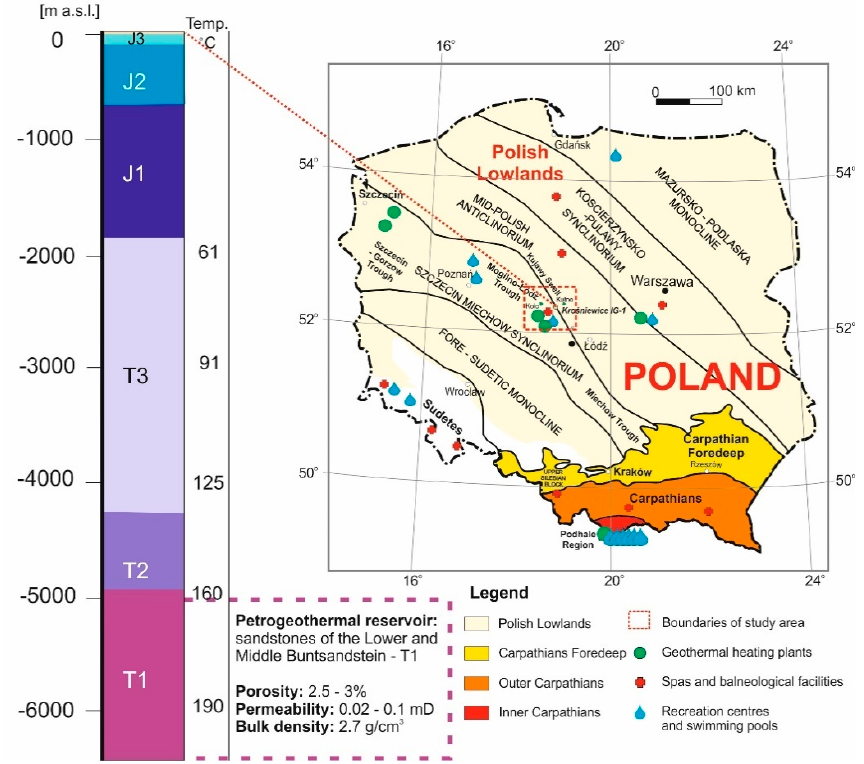
Figure 4. Location of the research area together with the predicted geological profile of Kro ś niewice IG-1.